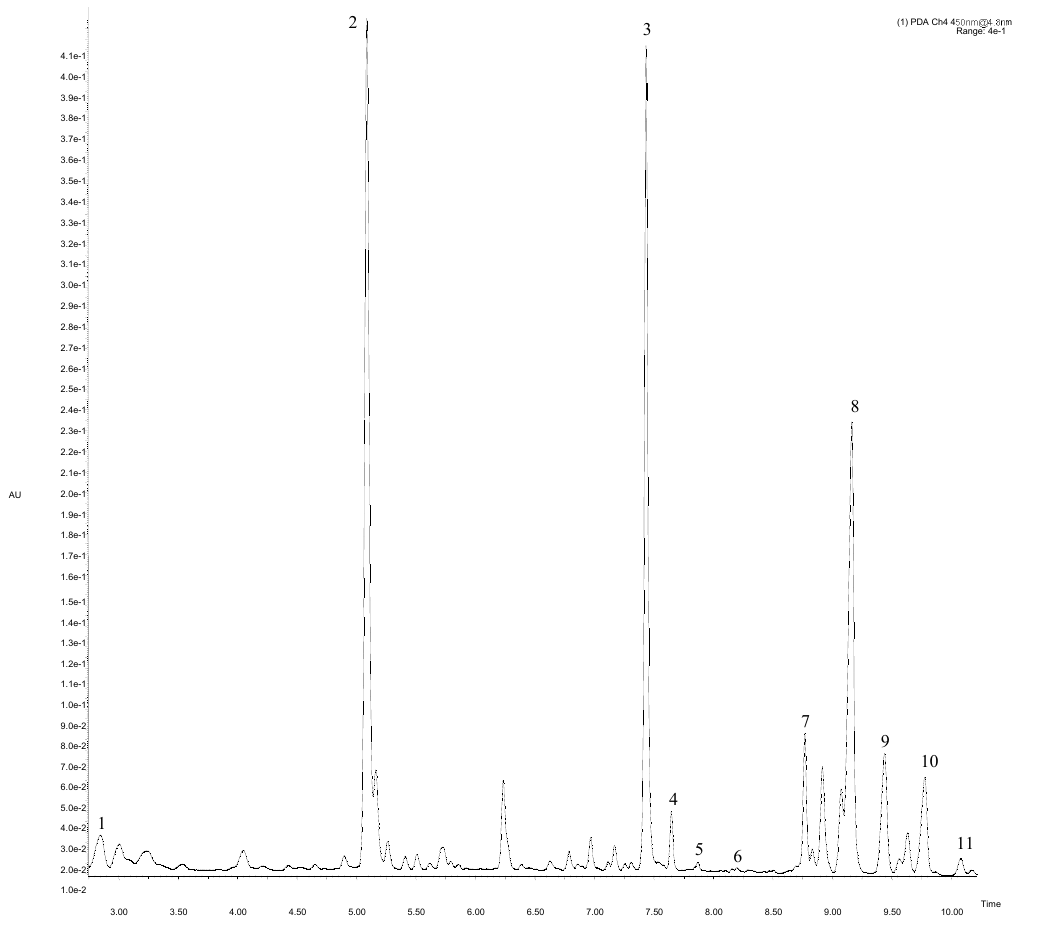
Figure 1. Main fragment of UPLC-PDA chromatogram at 450 nm of artichoke “Calico” cv. Peak number identities are display in Table 2.